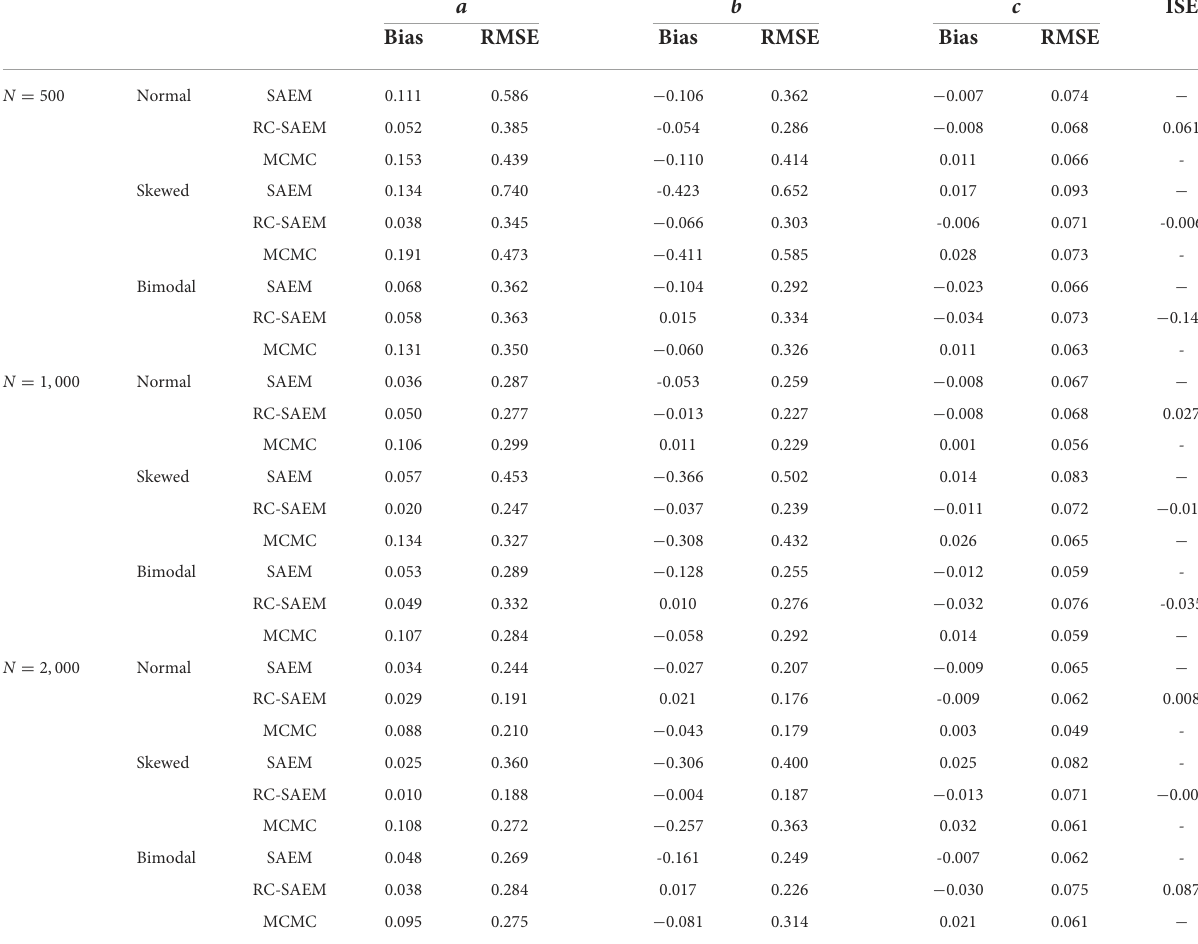
TABLE 6 Bias and RMSE of the item parameter estimates and the values of ISE statistic under different ability densities when the test length is 15. a b c ISE Bias RMSE Bias RMSE Bias RMSE